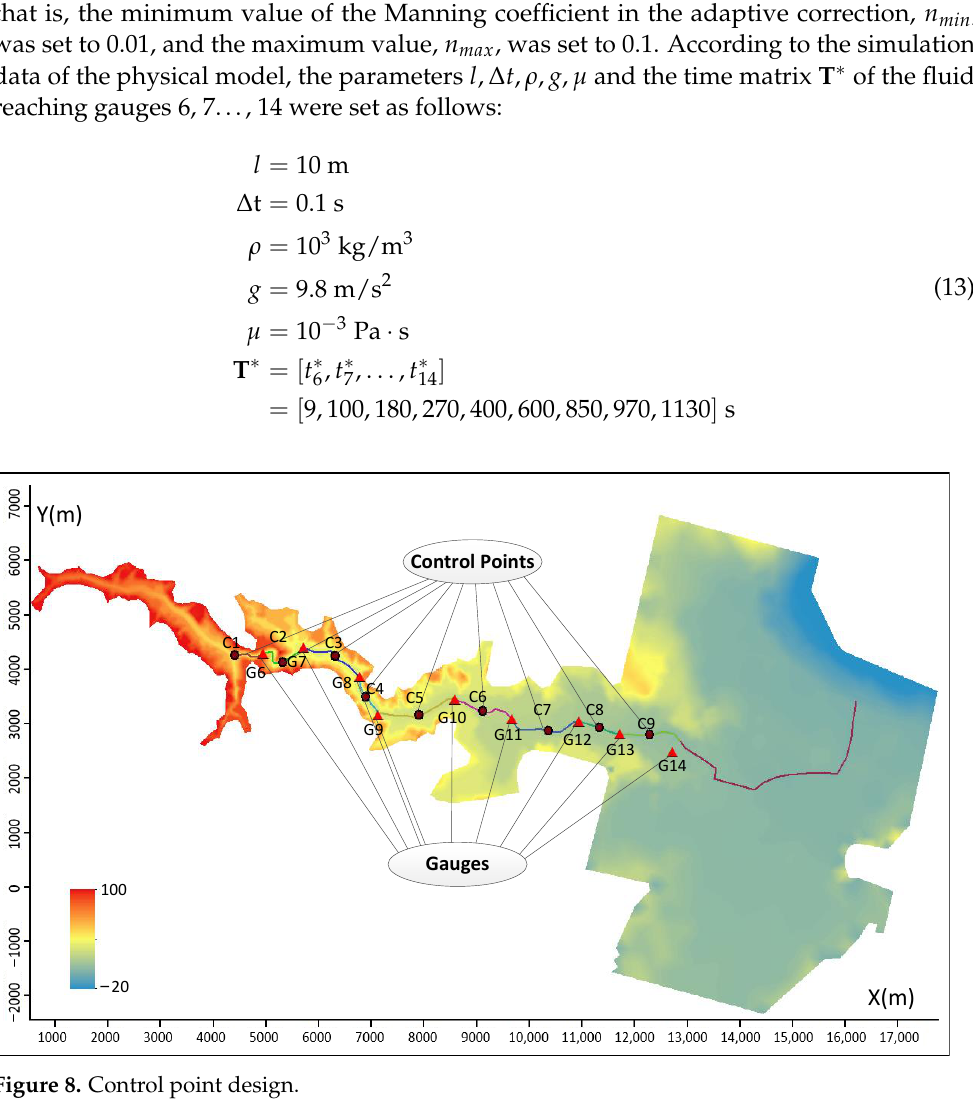
Figure 8. Control point